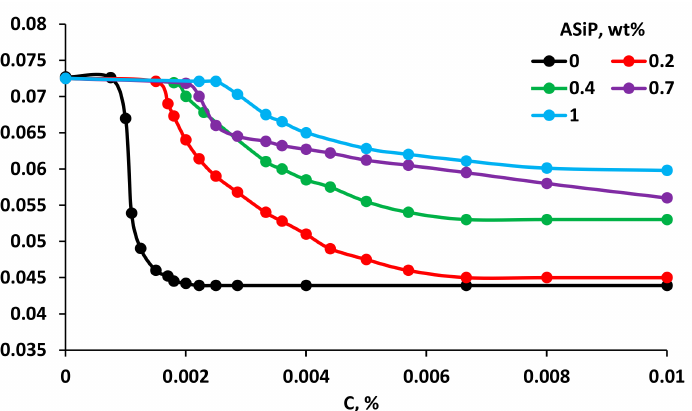
Figure 8. Surface tension isotherms ( σ , N/m) of MBC based on [PPEG]:[D4] = 1:15 obtained at different ASiP